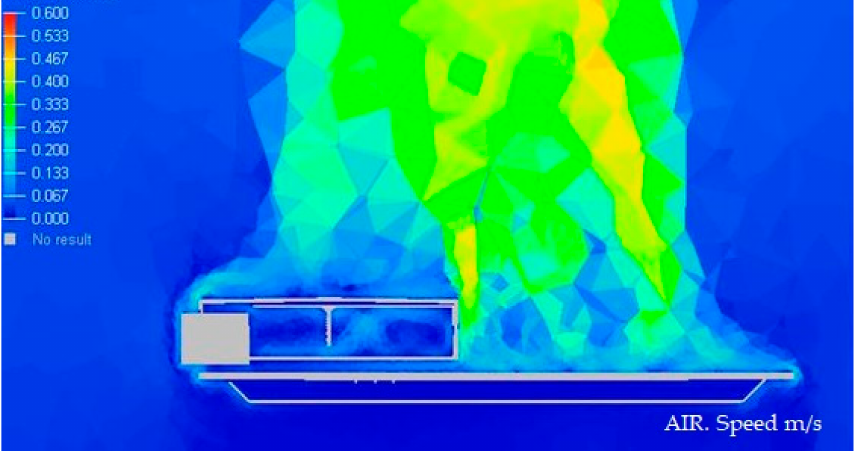
Figure 13. Speed section medium of the luminaire at − 10 ◦ C. Source: HyperView